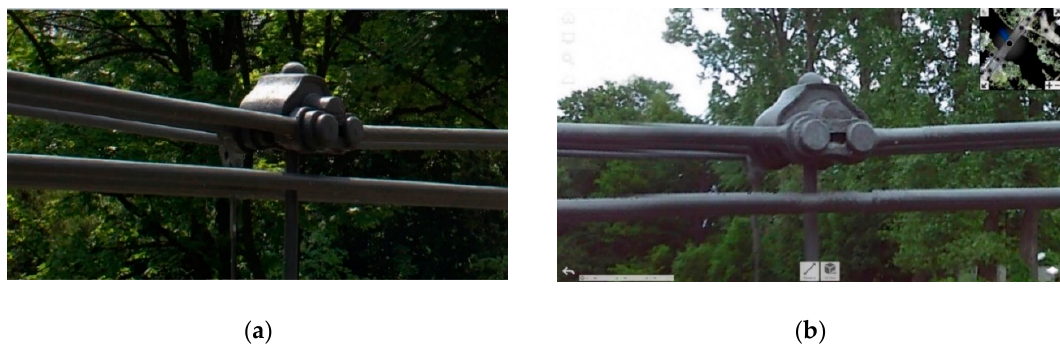
Figure 7. Detail of the bridge seen. ( a ) Stitched Panotool with limited measurement possibility; ( b ) from Recap Pro RealView offering measurement functionality.